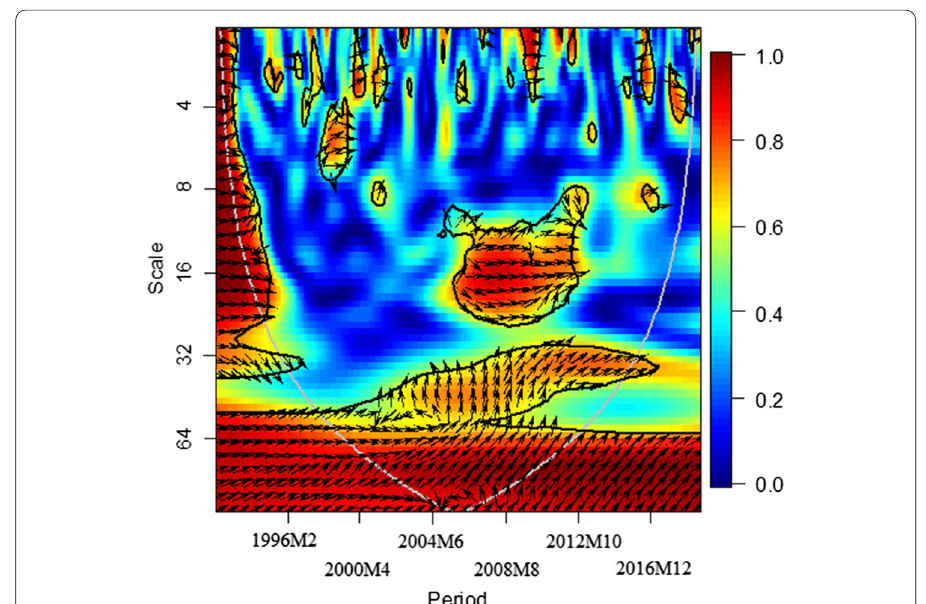
Fig. 7 Wavelet coherence between energy price index and industry input price index